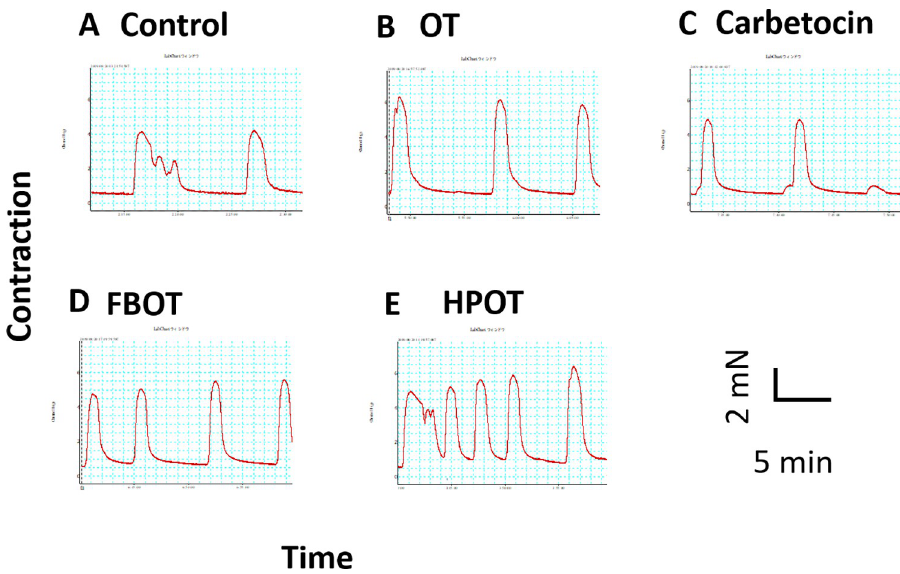
Fig 1. Representative ex vivo contractility traces of myometrial strips isolated from human caesarean sections. After establishing spontaneous rhythmic uterine contraction (A), effects of 1 nM oxytocin (OT, B ), carbetocin ( C ), FBOT ( D ), and HPOT ( E ) on spontaneous rhythmic uterine contraction were examined. Contractions were recorded for 6 min. The time interval between drug application and washing was 30 min.